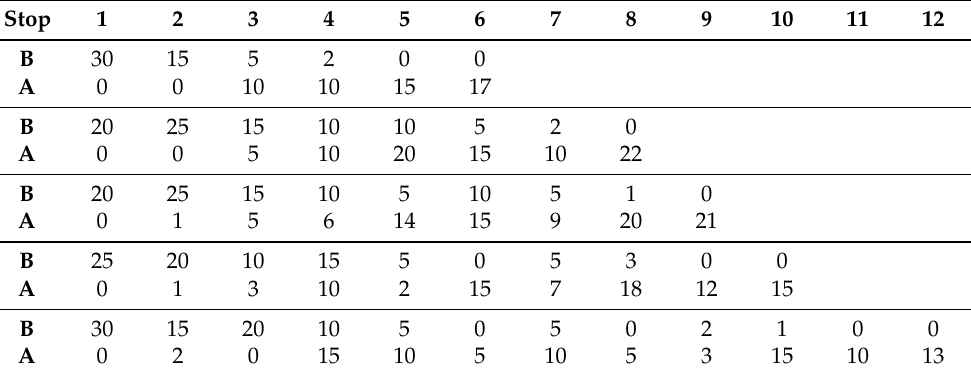
Table 3. Number of passengers boarding (B) and alighting (A) from the bus at each stop according to the length of the bus